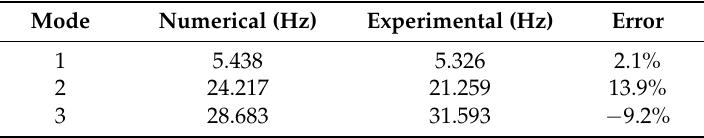
Table 4. First three natural frequencies of the piezoelectric smart plate.